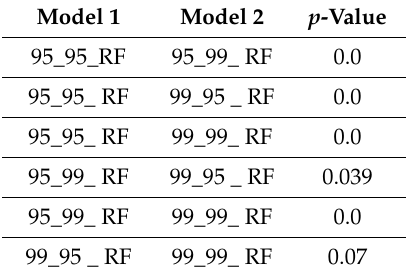
Table 16. p -value for t -test comparison for the RF models (tested against cleaned